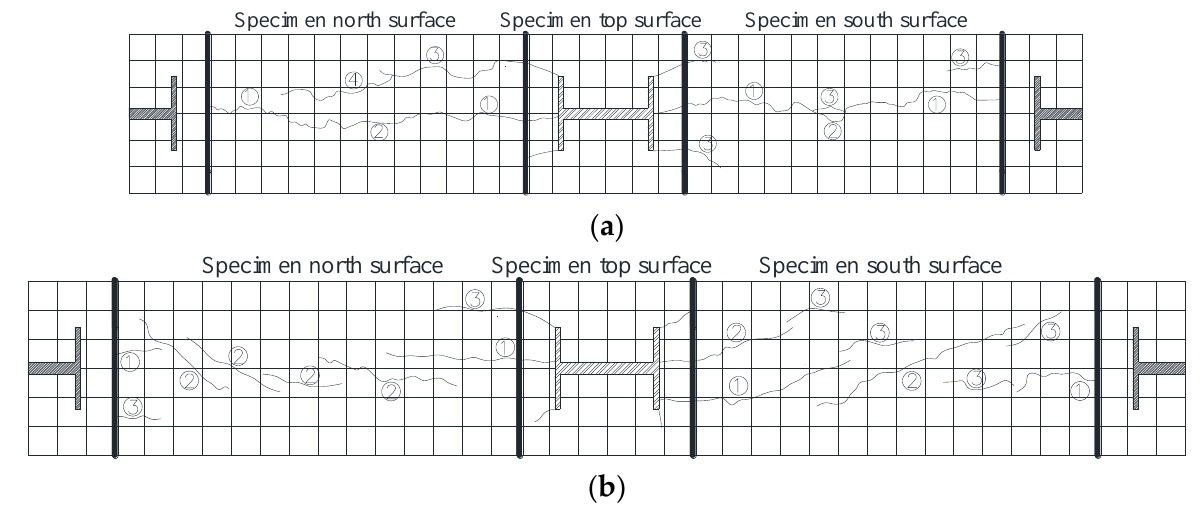
Figure 9. Typical side cracks in the specimens. ( a ) S-SFRAC15. ( b ) S-SFRAC08.